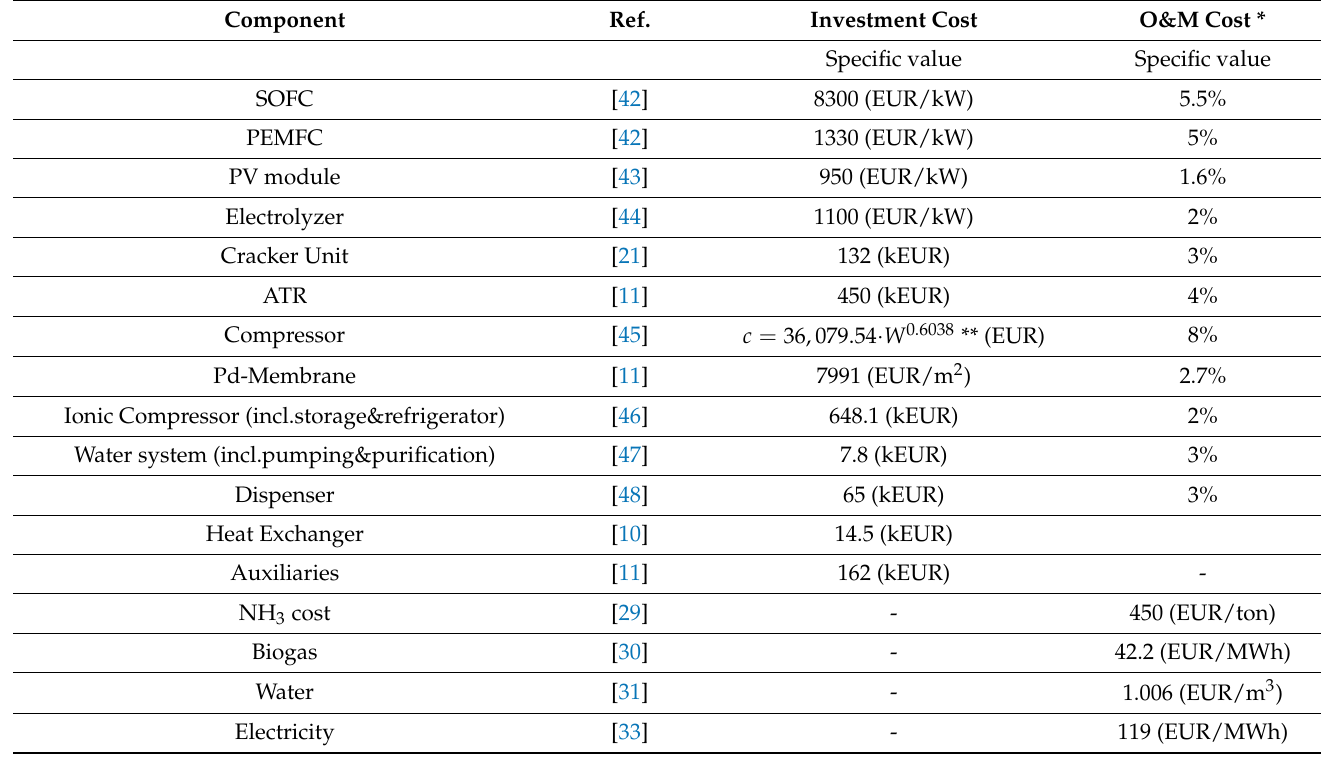
Table A3. Costs of the components used in the proposed configurations.